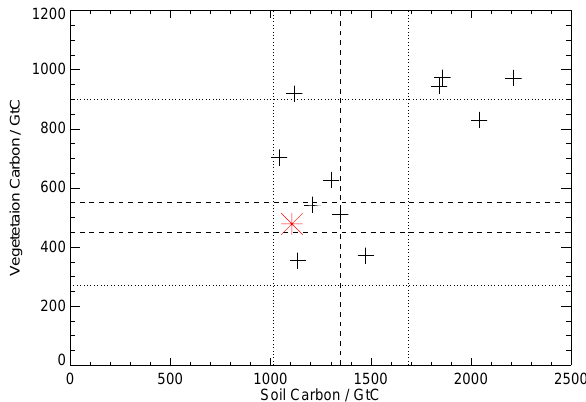
Fig. 17. Present day global total soil and vegetation carbon (GtC) from the 11 C 4 MIP models (black crosses) and HadGEM2-ES (red star) compared with estimated global totals of: biomass (Olson et al., 1985, present 2 central estimates of global vegetation carbon (dashed horizontal lines) and high and low confidence limits – dot- ted); soil carbon (Prentice et al., 2001, state a global estimate of 1350GtC not including inert soil carbon – dashed vertical line). In the absence of estimated uncertainty range for soil carbon we choose ± 25% as a reasonable tolerance (dotted lines).